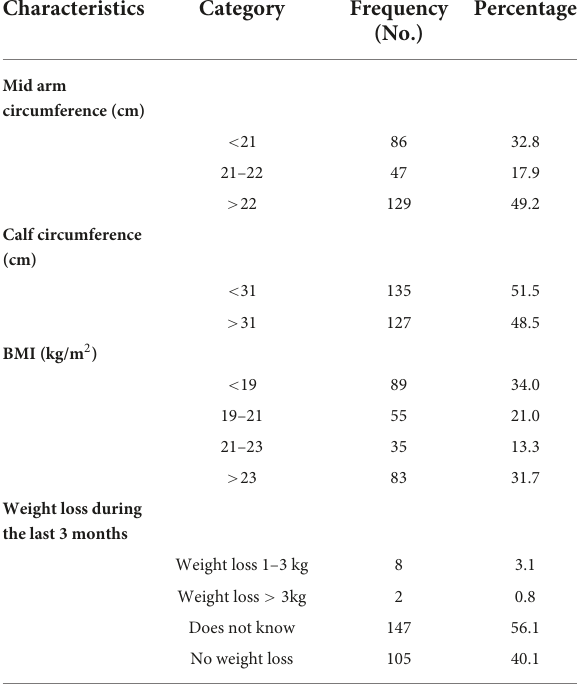
TABLE 4 Anthropometric assessment of older adult patients with heart failure at Cardiac Clinic, University of Gondar hospital, June 01, 2021 to October 31, 2021 (No.